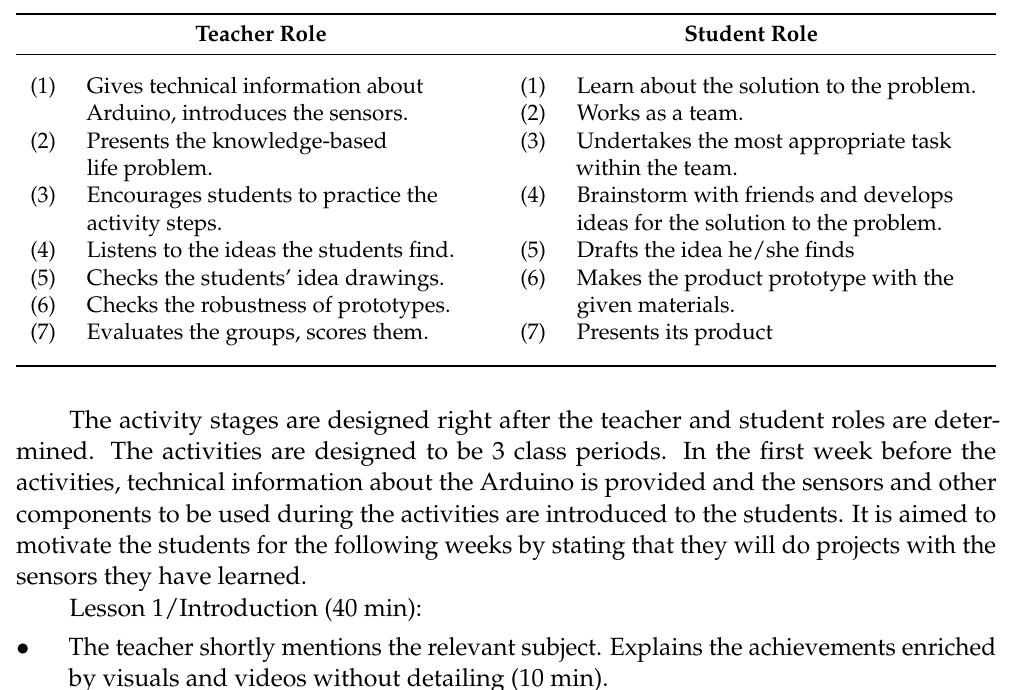
Table 1. Teacher and Student